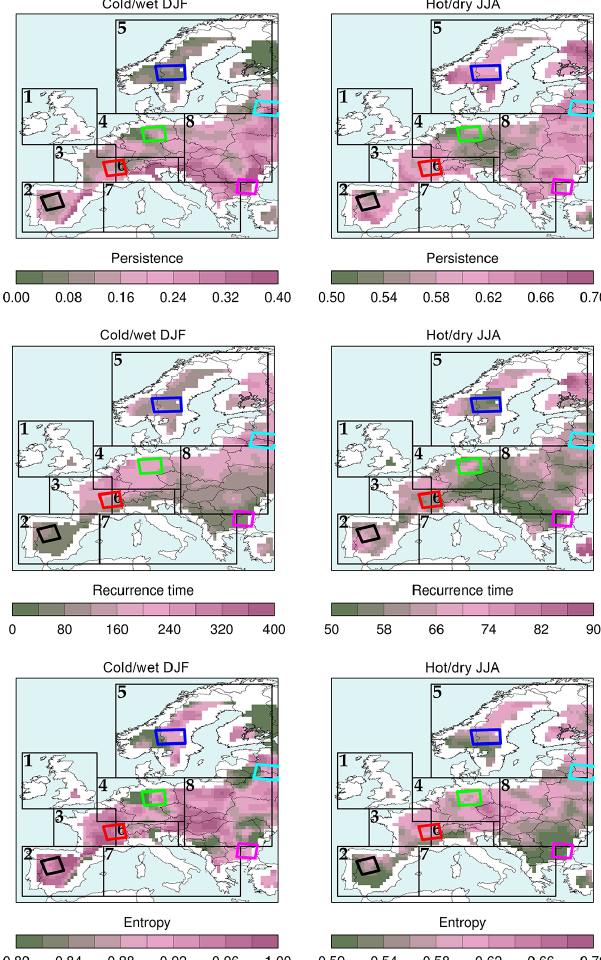
Figure 2. Elevation of the CCLM 50km model domain [m]. Boxes mark the six investigation areas – 1: Spain (black), 2: France (red), 3: Germany (green), 4: Scandinavia (blue), 5: Russia (cyan) and 6: Bulgaria